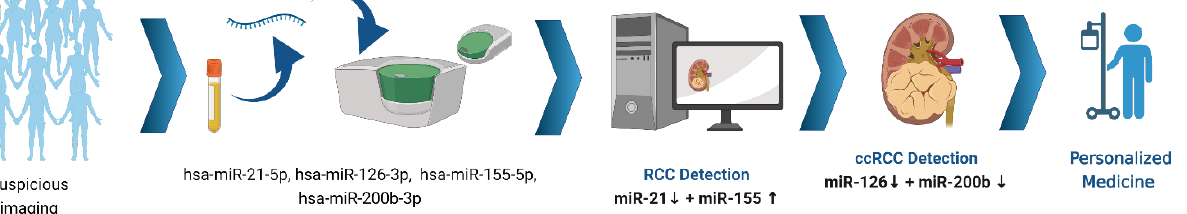
Figure 6. Graphical representation of the potential clinical impact of LiKidMiRs. Created with BioRender.com.